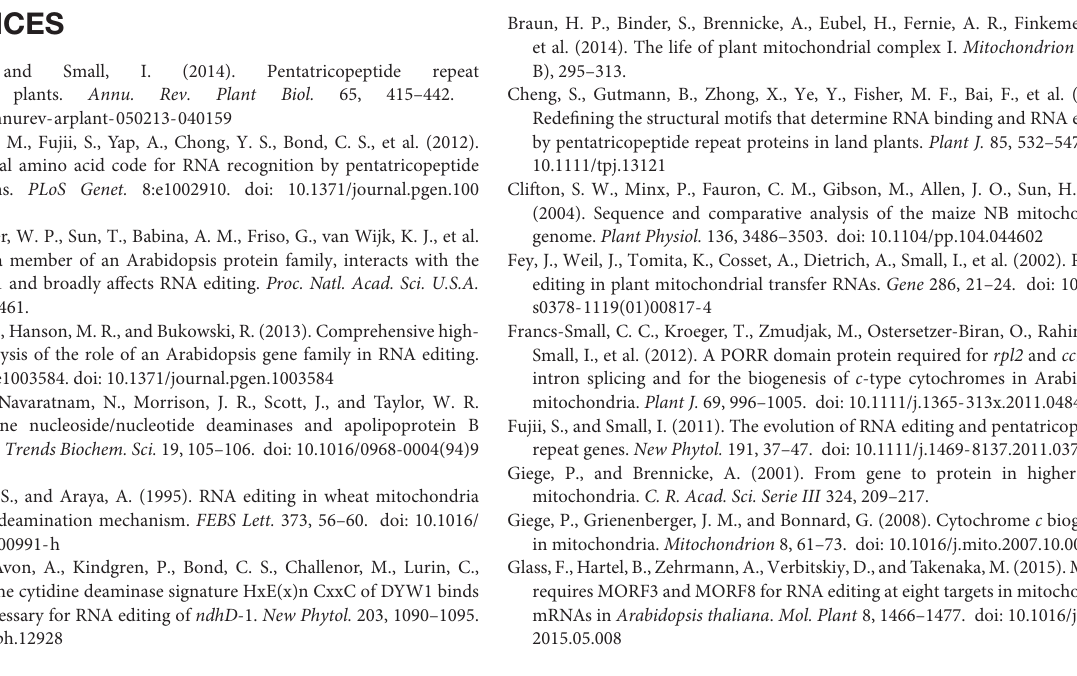
Supplementary Figure 1 | The alignment of the DYW domains within PpPPR56, PpPPR65, and EMP17. Supplementary Figure 2 | The transcription profiling of Emp17 in wild type. Supplementary Figure 3 | The Linkage analysis of emp17 . Supplementary Figure 4 | Transcription profiling of the 35 mitochondrial protein-coding genes in wild type and emp17 . Supplementary Figure 5 | The co-evolutionary relationship between EMP17 and the editing sites controlled by EMP17. Supplementary Table 1 | Primers used for the